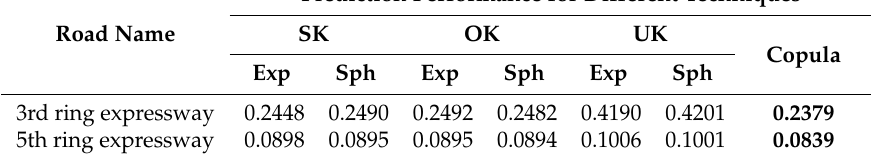
Table 5. Comparison between copula and kriging based on MAPE at 8:00 (timestamp = 240) on